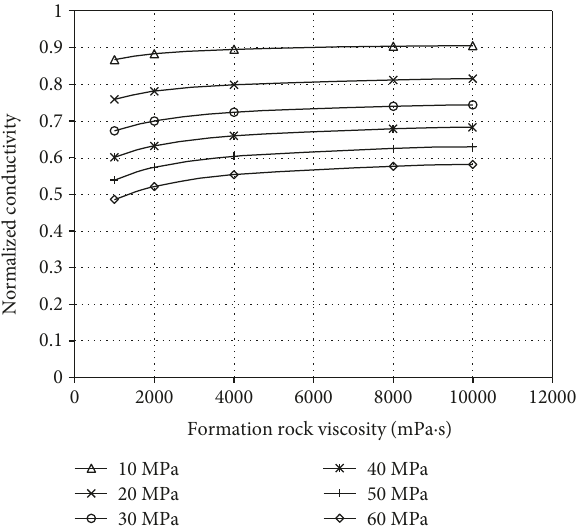
Figure 3: E ff ect of E n on fracture conductivity at di pressures.